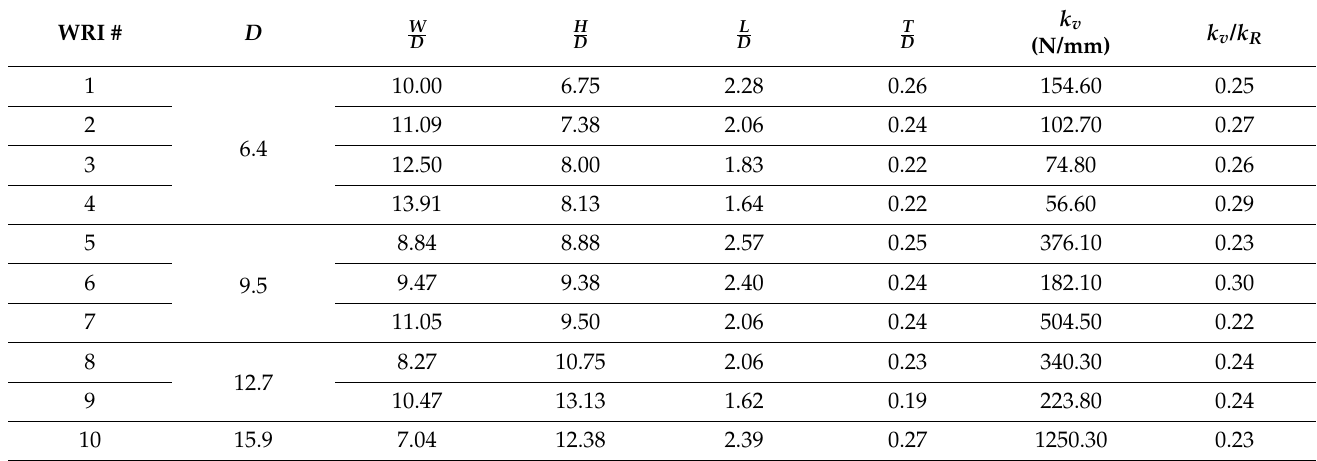
Refer to Figure 2. D : diameter (mm); W : width (mm); H : height (mm); L : length (mm). k v : static vertical stiffness (N/mm);